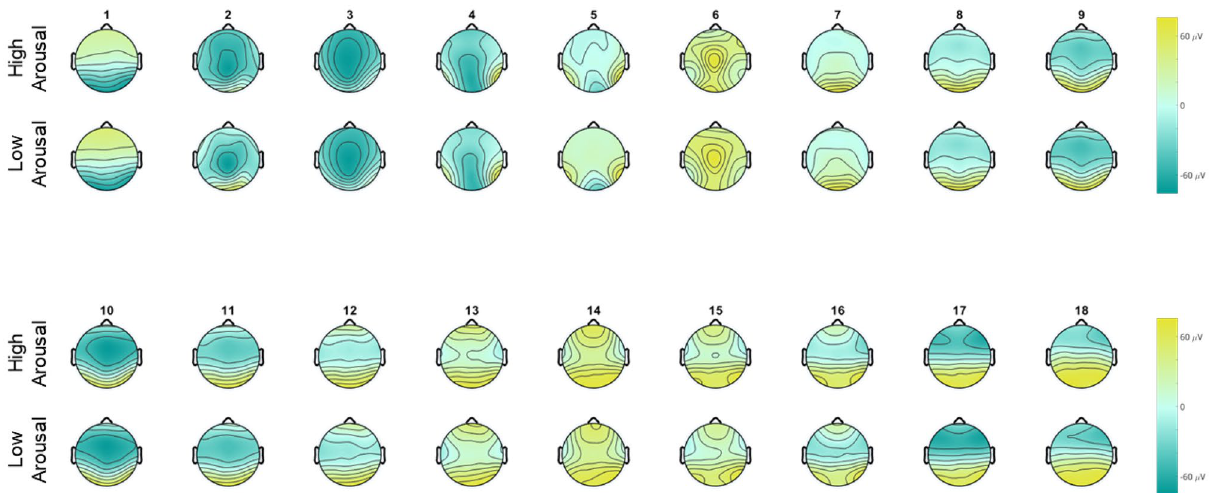
Figure 4. Microstates of actively viewing high and low emotional arousal pictures. Head seen from above, nose up. Microstates are numbered 1–18. No global differences emerged in the TANOVA, so no tests for local differences were conducted. Colors range from − 76 μV (teal) to + 76 μV